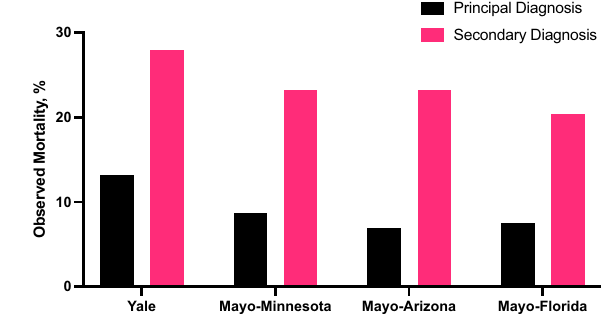
Fig. 5 Mortality for COVID-19 hospitalizations de fi ned by principal and secondary diagnosis by study site. Mortality represents inhospital death and discharge to hospice from index